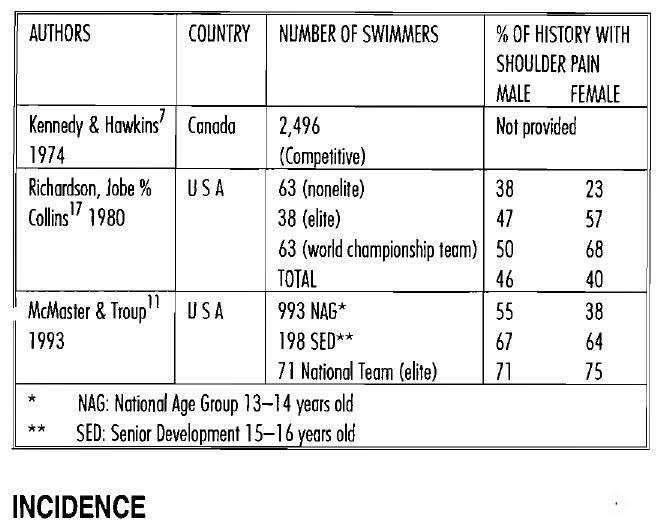
TABLE II: SWIMMER WITH A HISTORY OF SHOULDER PAIN